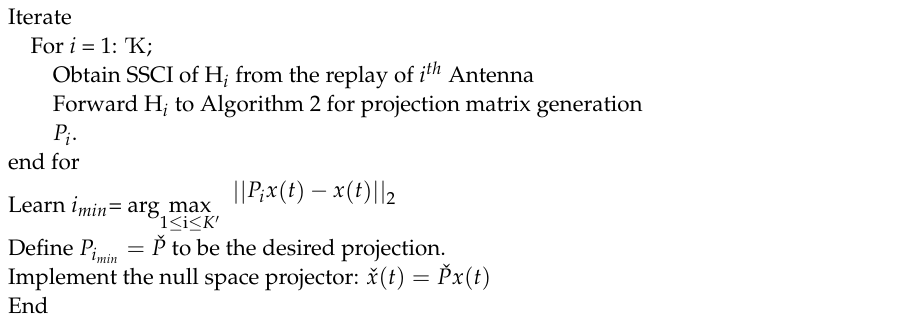
Algorithm 1 . Projection for Algorithm 1 on 1st Scenario.